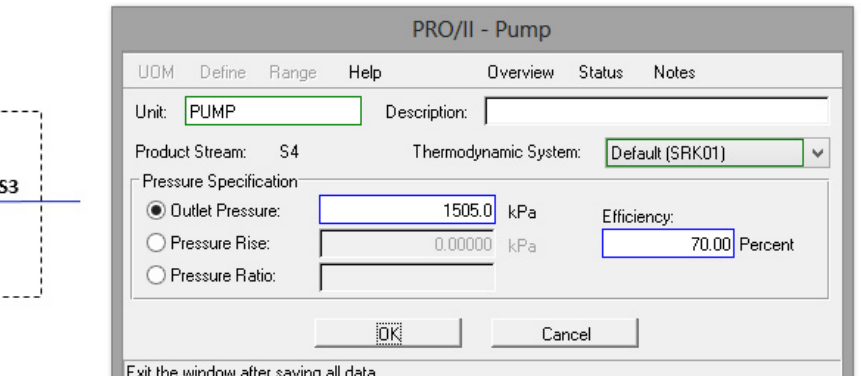
Figure 4. Pump properties